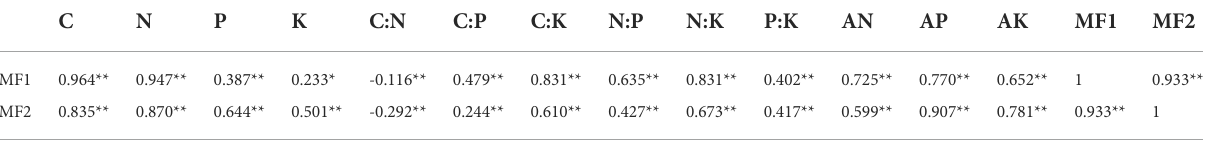
TABLE 1 Correlation between individual soil functions and soil multifunctionality